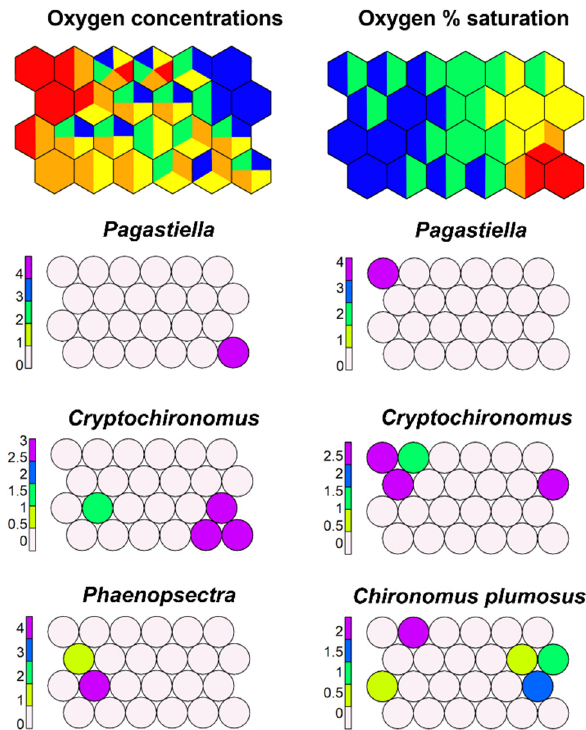
Figure 21. Supervised map of sites and three morphotaxa clustered, respectively, using dissolved oxygen (in mg − 1 ) and oxygen % saturation as external variable. Oxygen range: Blue, >11 mg − 1 ; green, 10–11 mg − 1 ; yellow, 9–10 mg − 1 ; orange, 5–9 mg − 1 ; red, <5 mg − 1 . Oxygen % saturation range: Blue, >100%; green, 80–100%; yellow, 60–80%; orange, 40–60%; red, <40%.